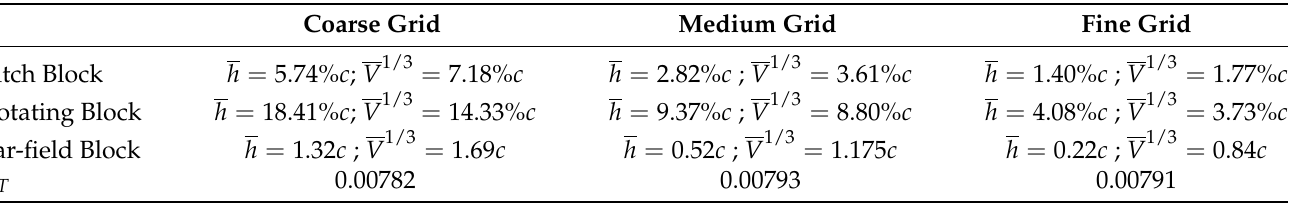
Table A1. Grid spacings and numerical results. Coarse Grid Medium Grid Fine